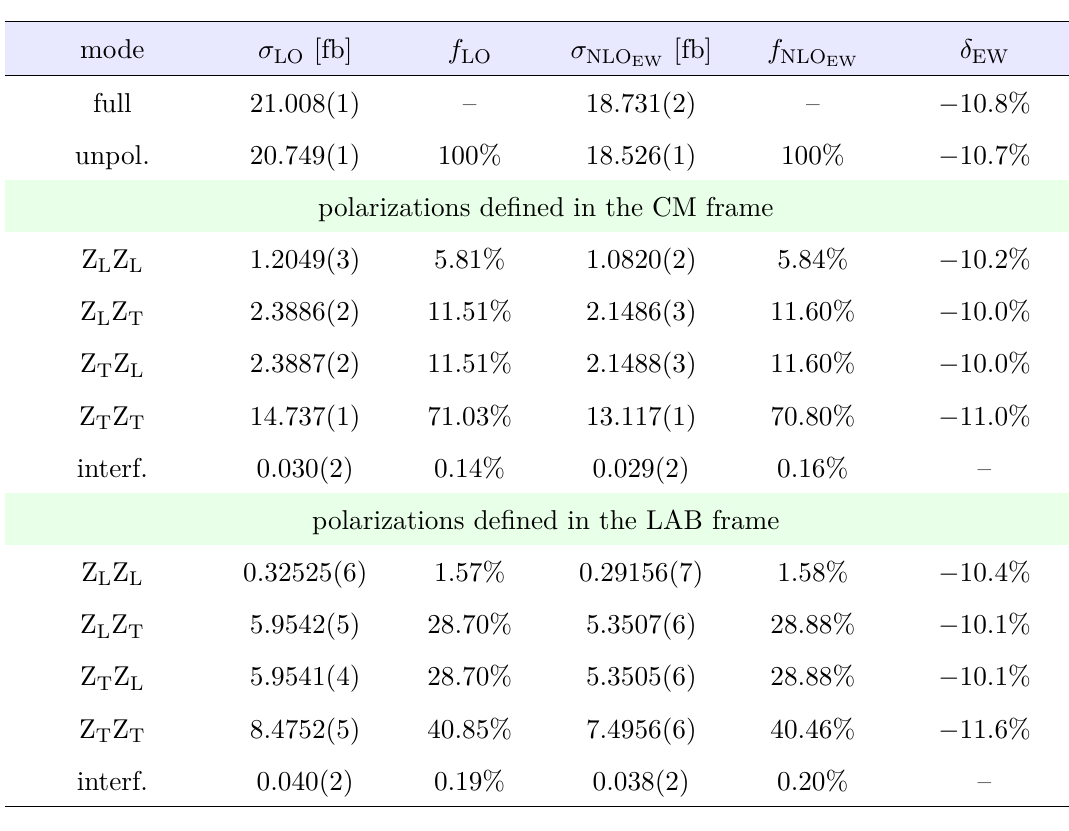
Table 2 . Integrated cross-sections in the INC setup (see section 2.5) for unpolarized and doubly- polarized ZZ production at the LHC at LO and NLO EW accuracy. The polarization fractions are computed as ratios of polarized cross-sections over the unpolarized DPA one at f LO , f NLO EW LO and at NLO EW, respectively. The NLO EW corrections are shown in the right-most column, as percentages relative to LO cross-sections ( δ ). The full results are obtained including all EW doubly-resonant and non-doubly-resonant contributions, while all other results are based on the DPA described in section 2.2. Interference contributions are obtained by subtracting the sum of polarized results from the DPA unpolarized one. Numerical errors are shown in